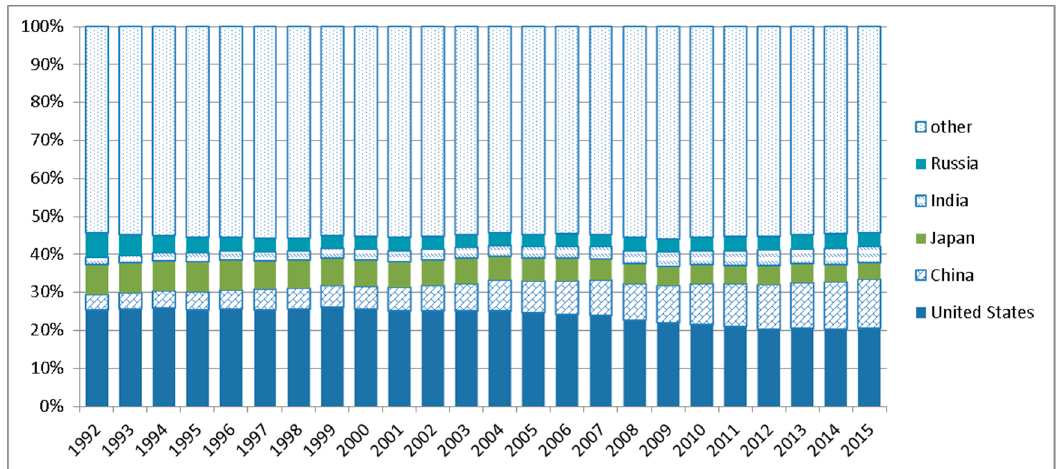
Figure 3. Dynamic frequency connectedness for volatilities.